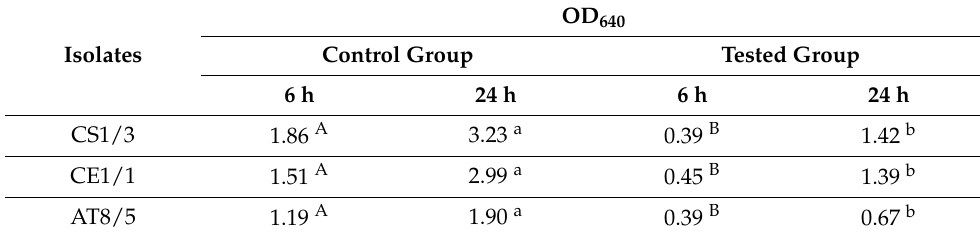
Table 1. Effect of bile salt on the growth of some bacterial isolates. The uppercase letters show the comparison of the OD 640 value of each isolate in the tested and control group at an incubation period of 6 h; the lowercase letters show the comparison of the OD 640 value of each isolate in the tested and control group at 24 h of incubation; different letters in each column show a statistically significant difference.